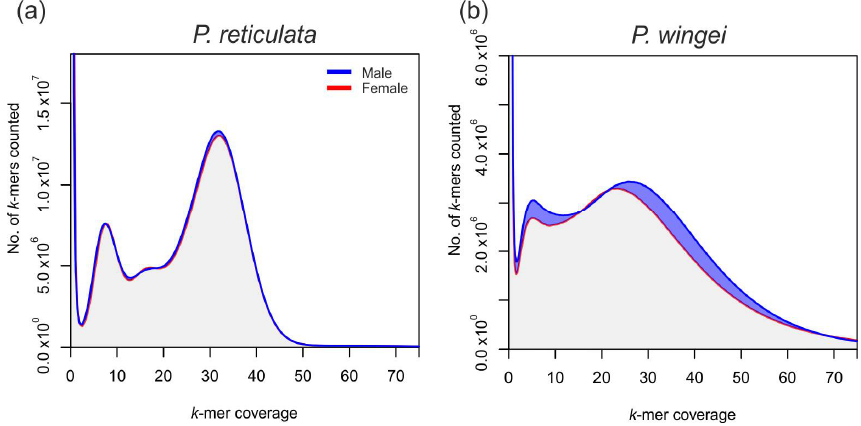
Figure 2. Male (blue) and female (red) k -mer coverage profiles in ( a ) P. reticulata and ( b ) P. wingei .